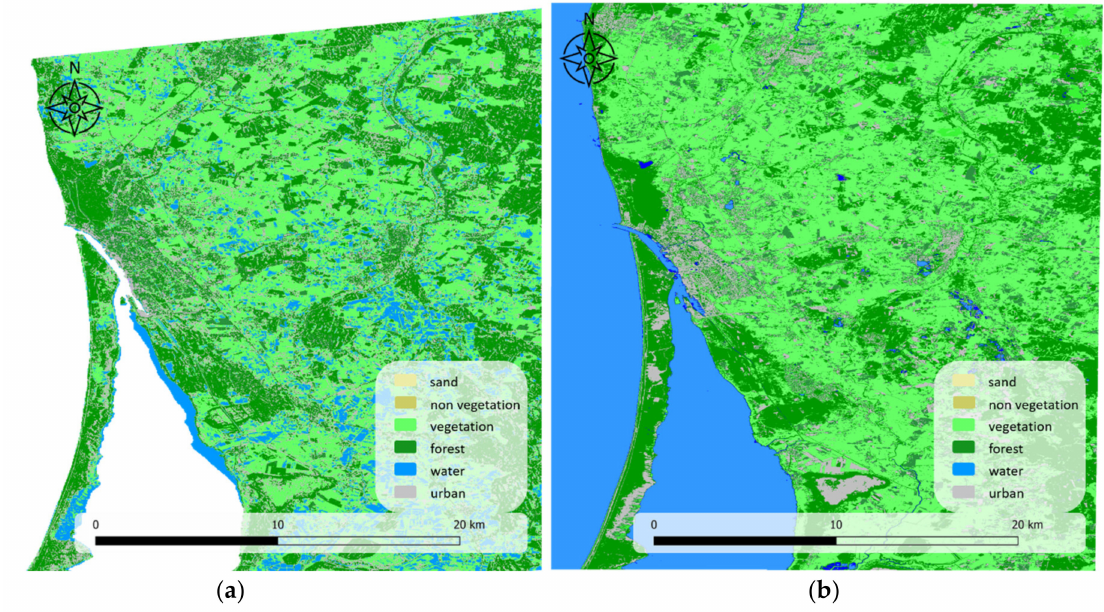
Figure 11. Segmentation result: ( a ) SAR (2018); ( b ) MSI